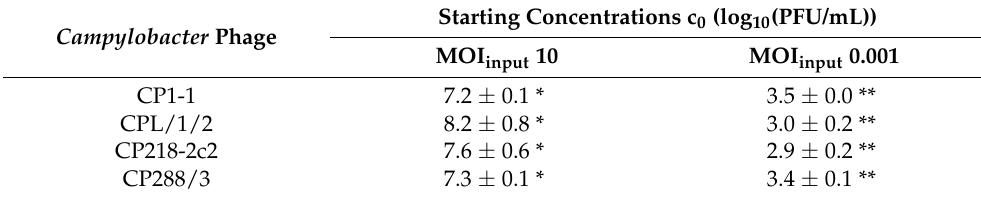
Table 4. Mean phage concentrations (c 0 ) at the beginning of single-phage planktonic killing assays (log 10 (PFU/mL)).